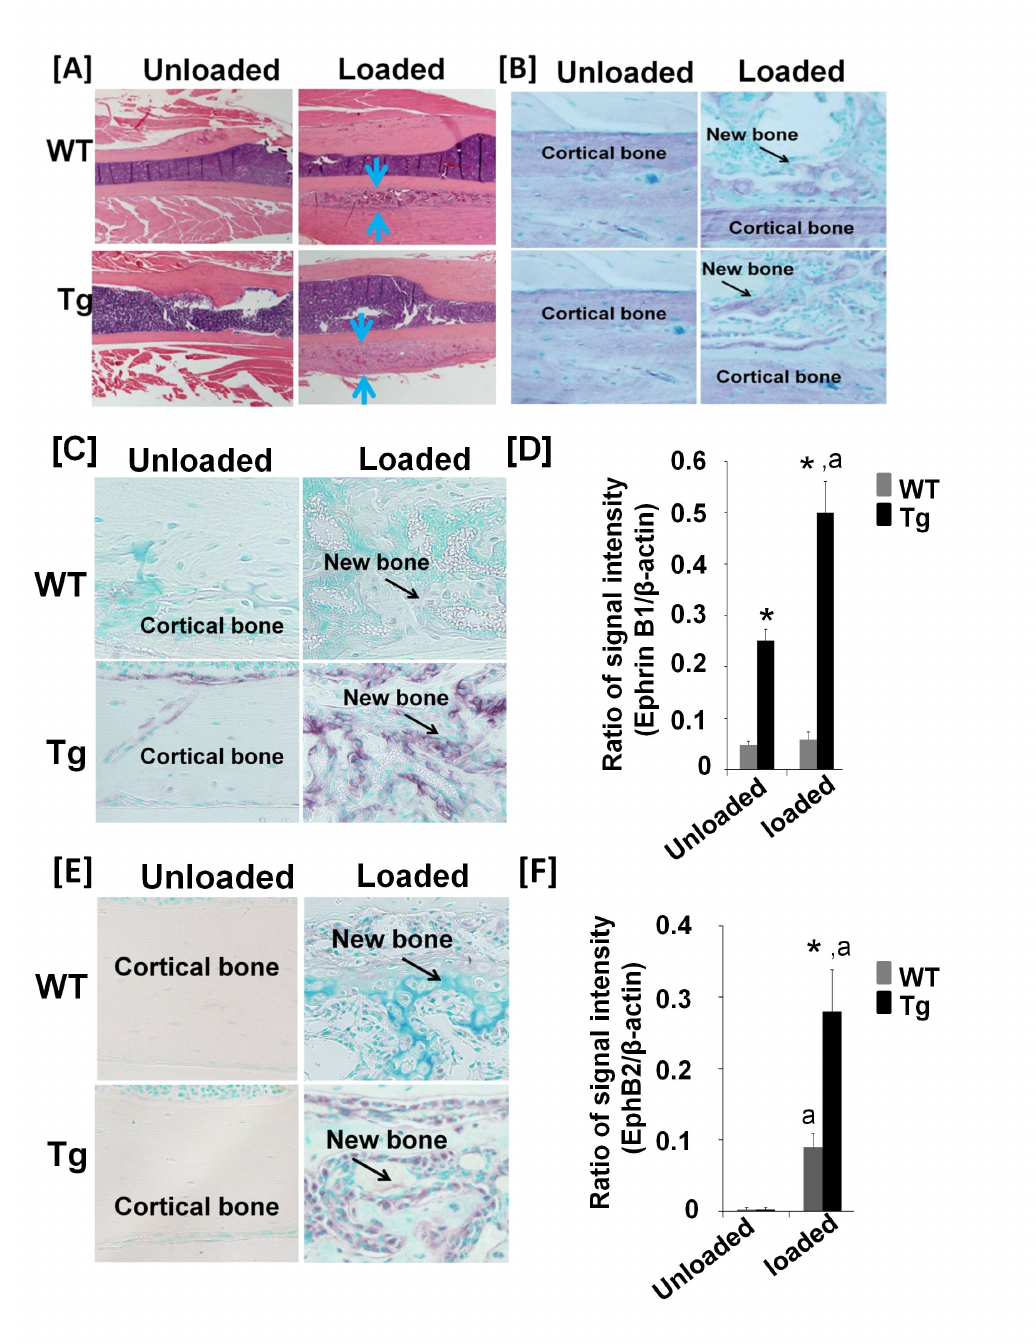
Figure 7. Mechanical loading stimulates bone formation and EphB2 and EphB4 expression in newly formed bone in transgenic mice. Tibia mid shafts from 12-week old WT and Tg, stained with H & E [A] . The right tibias of the 10-week old mice were loaded for 2 weeks, and the left tibias served as an unloaded control. Arrows indicate newly formed bone in response to mechanical loading. Expression of osteocalcin [B] , ephrin B1 [C] , and EphB2 [E] in newly formed bone are detected by immunohistochemistry. Quantitative data of ephrin B1 [D] and EphB2 [F] expression in newly formed bone, detected by immunohistochemistry are presented as the means ± SEM for N = 5 (3 pairs of littermate males and 2 pairs of littermate females). A star represents statistical significance (P < 0.01) when compared to WT littermate controls. “a” indicates statistical significance (P < 0.01) when compared to unloaded bones of the Tg mice. doi: 10.1371/journal.pone.0069051.g007 PLOS ONE |